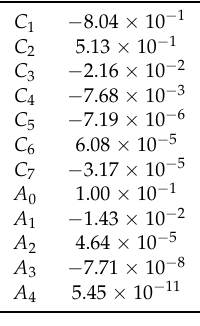
Table 5. Coefficient values determined for the weighting function